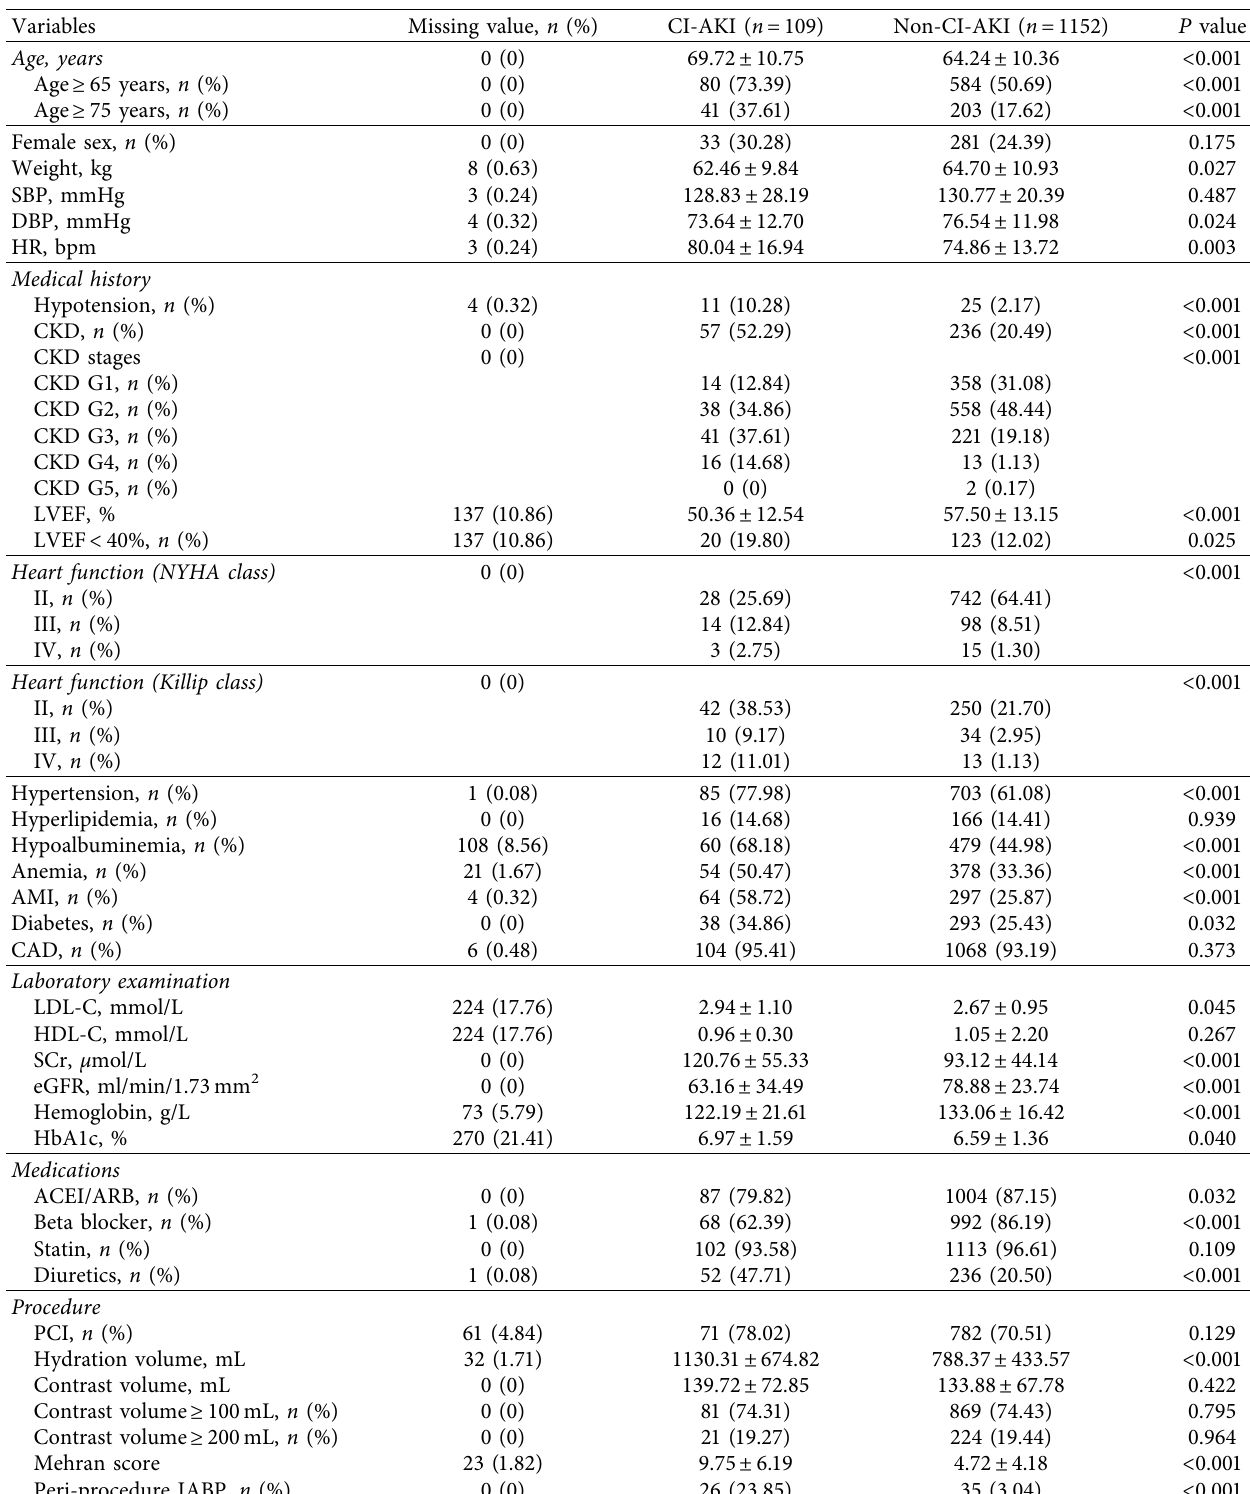
Table 1: Baseline characteristics in the development